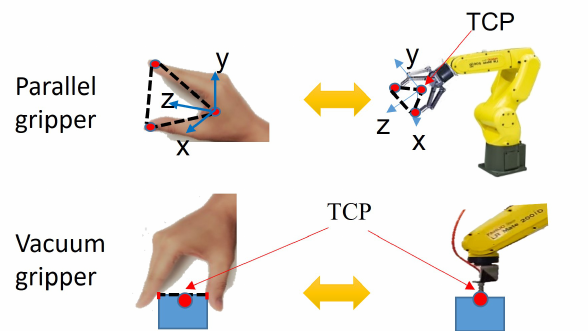
Figure 3. The hand gesture mimics both parallel and vacuum